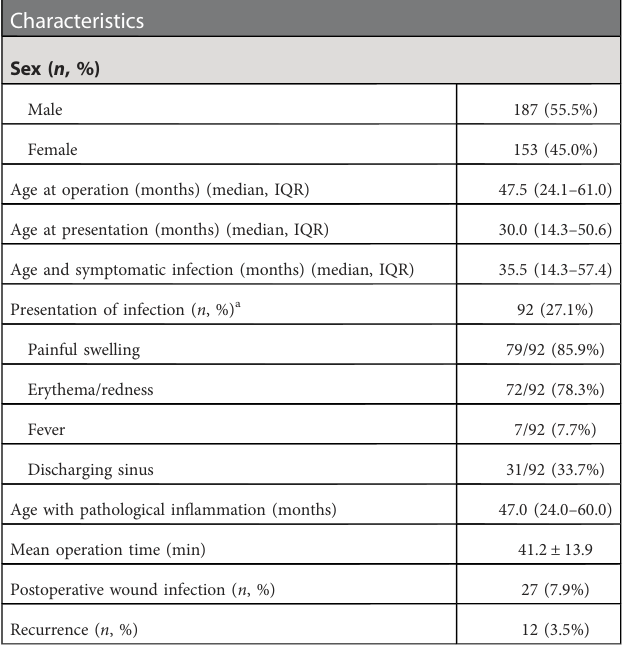
TABLE 1 Demographics and clinical characteristics of